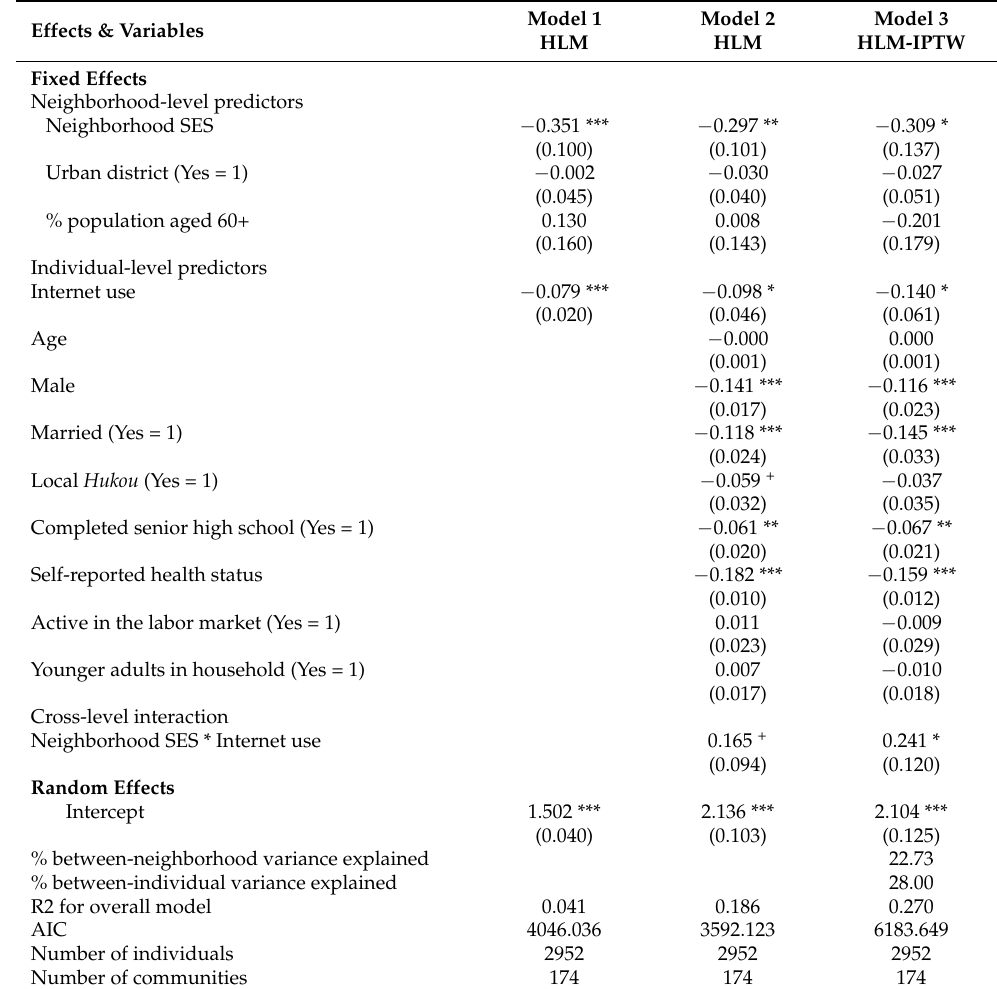
Table 3. Coefficients of multilevel linear regression of neighborhood characteristics and internet use on mental distress among older adults in Shanghai: SUNS